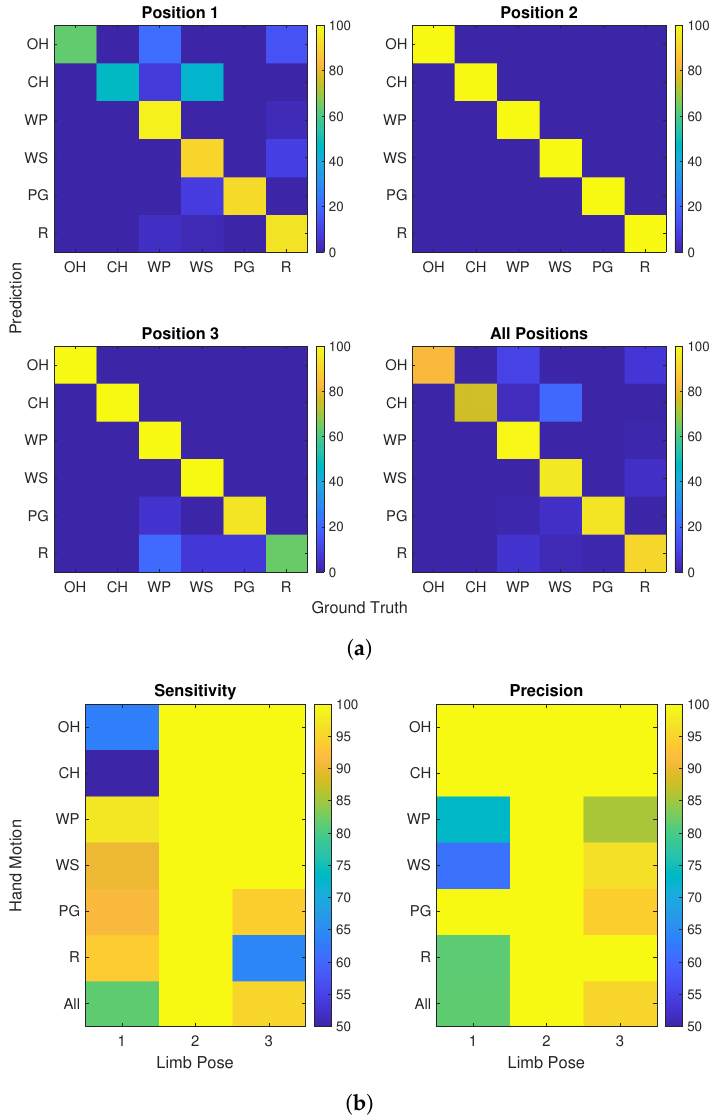
Figure 14. Performance evaluation separated by hand motion and limb position for subject 10 (after 3 k-fold). Sample classifier trained and evaluated with the calibration set including six different hand motions ( oh , ch , wp , ws , pg , r ) and three different limb poses (3:1 split). ( a ) Normalized confusion matrices per limb pose and overall, ( b ) Performance evaluation measures in % per hand motion (row) and limb pose